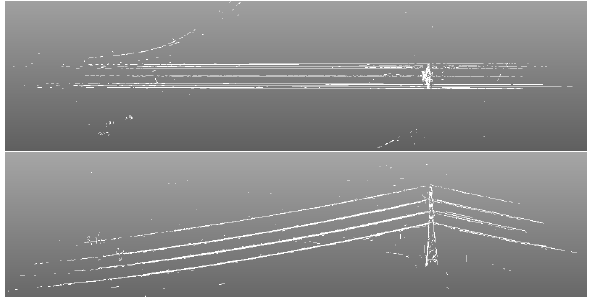
Figure 9. Reconstructed lines of Set1 depicted from top- and side-view: It can be seen, that the power lines as well as the pylon are reconstructed accurately.